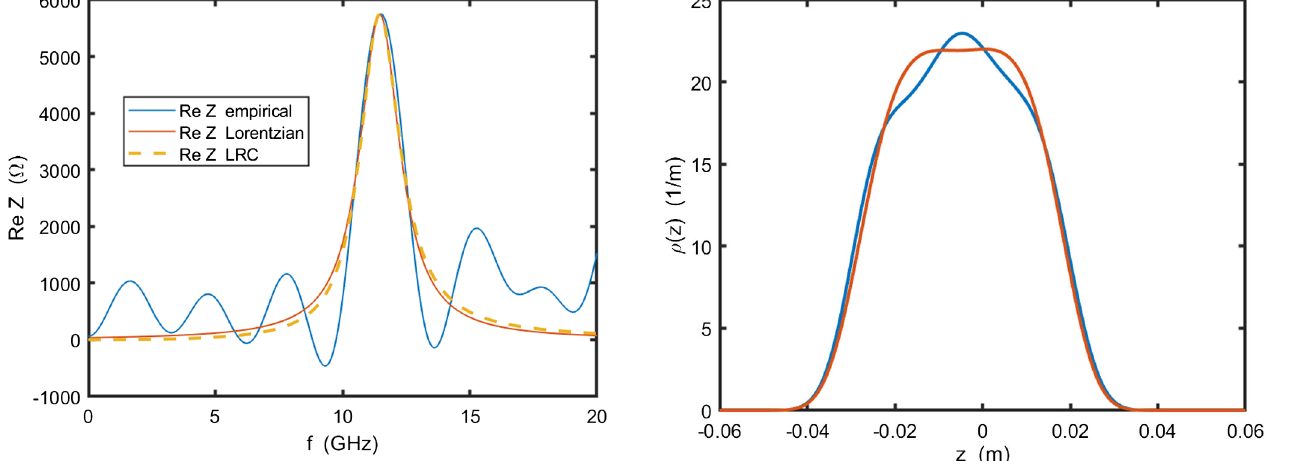
FIG. 17. Charge density for a complete fill, with HHC plus the first peak in the short range impedance (blue), and with HHC ¼ 500 mA. alone (red). I av